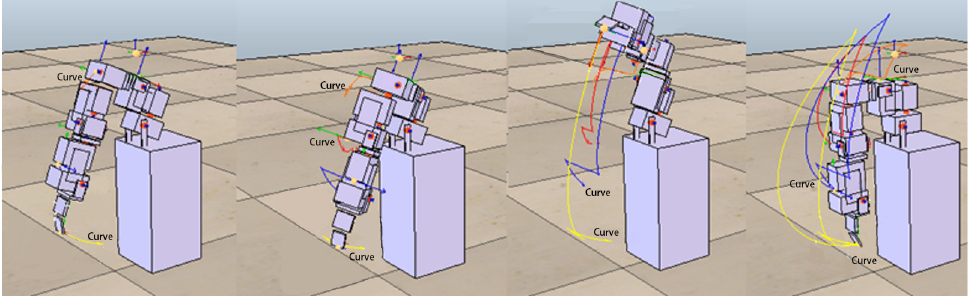
Figure 9. The motion trajectory of the shrugging → swinging → side-lifting action. The robot arm performs three actions in sequence, including shrugging, swinging, and